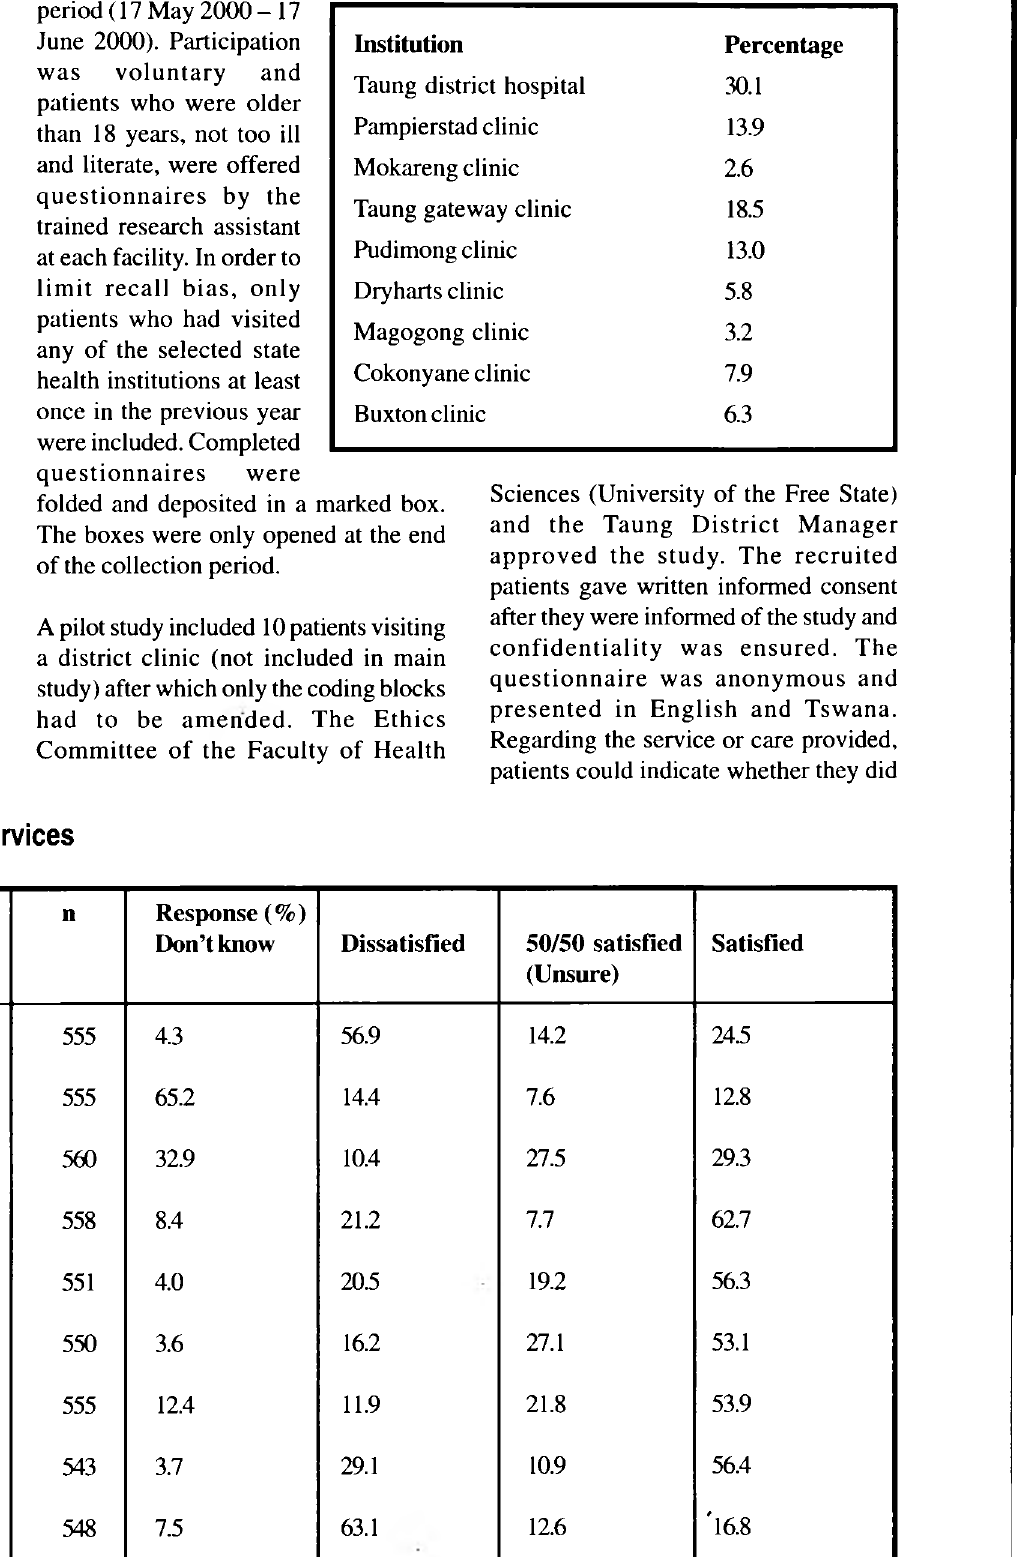
Table 1: Health institution attendance (n=566)